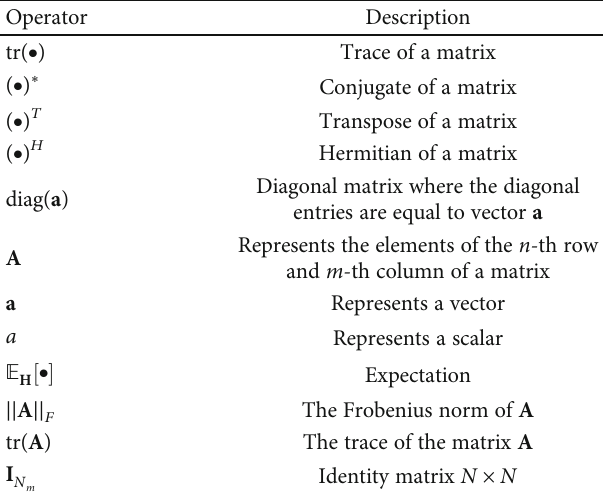
Table 1: Notation adopted in the